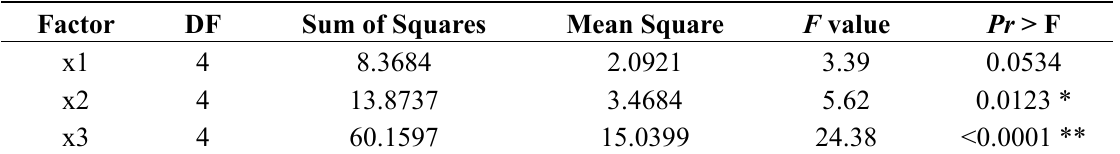
Table 4. Analysis of variance (ANOVA) for three factors for optimization of ganoderic acid Me (GA-Me) production of G. lucidum